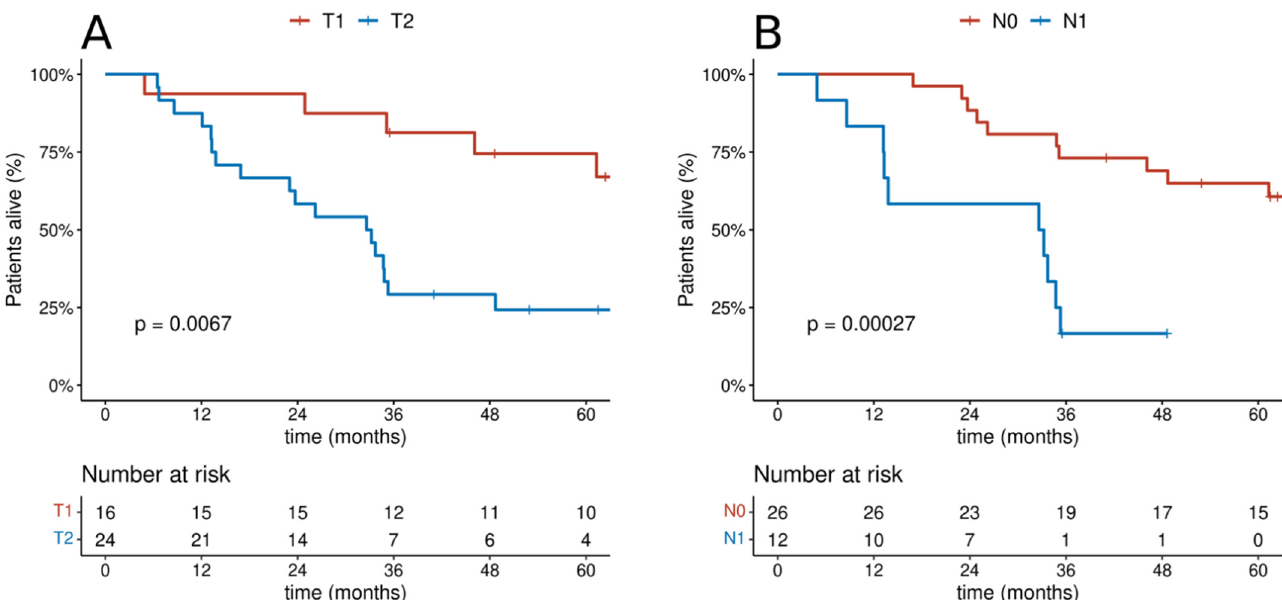
Figure 4. Cumulative probability of overall survival in the group of patients receiving radical treatment according to categories: ( A ) T; ( B ) N.